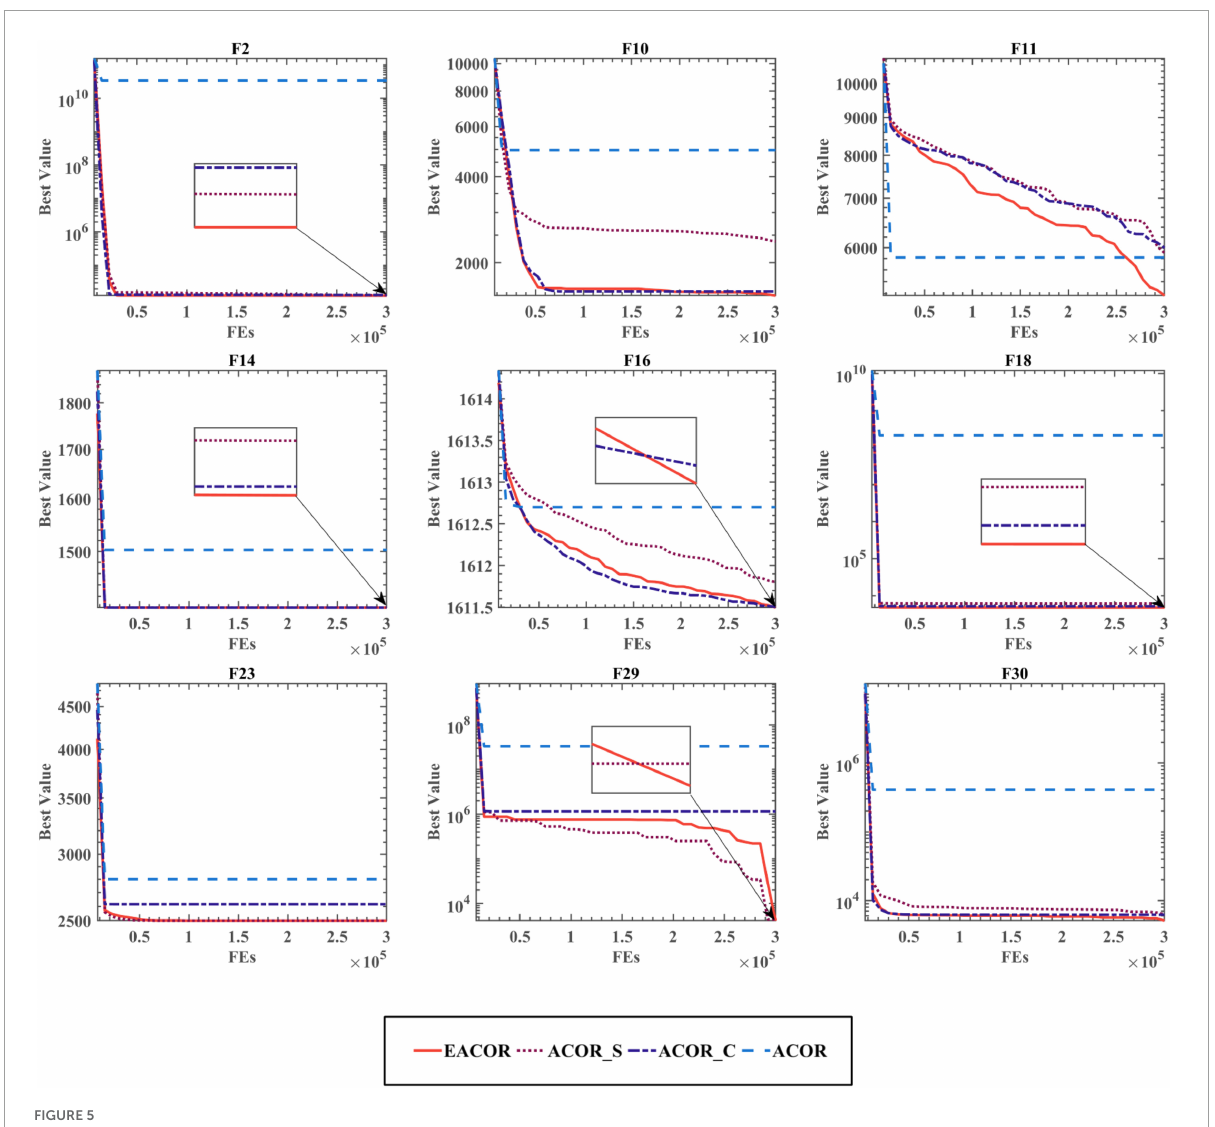
FIGURE5 The convergence curve of the EACOR strategy